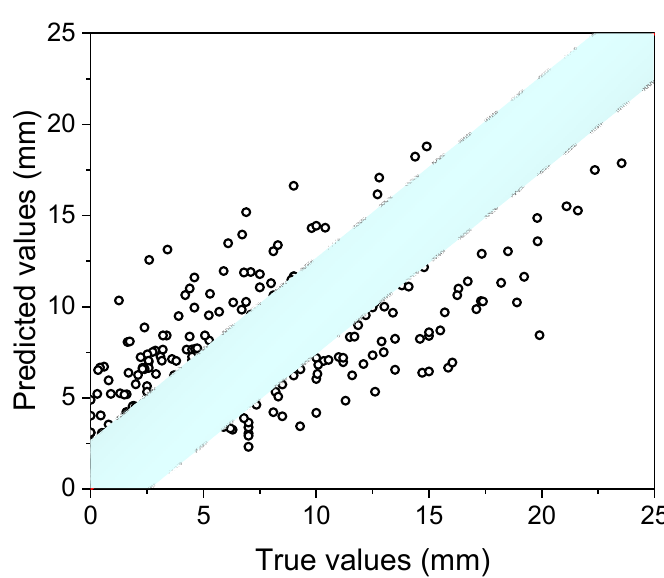
Figure 7. Illustration of 5-fold cross-validation.